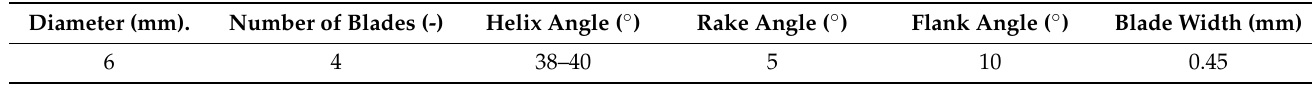
Table 7. Geometric parameters of the endmill.